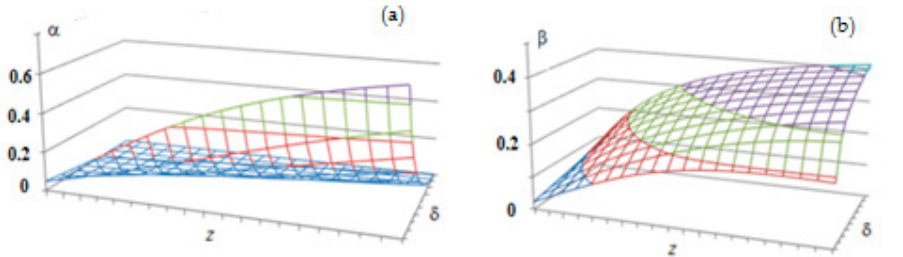
Figure 5. Probability of false failures ( a ); probability of undetected failures ( b ).